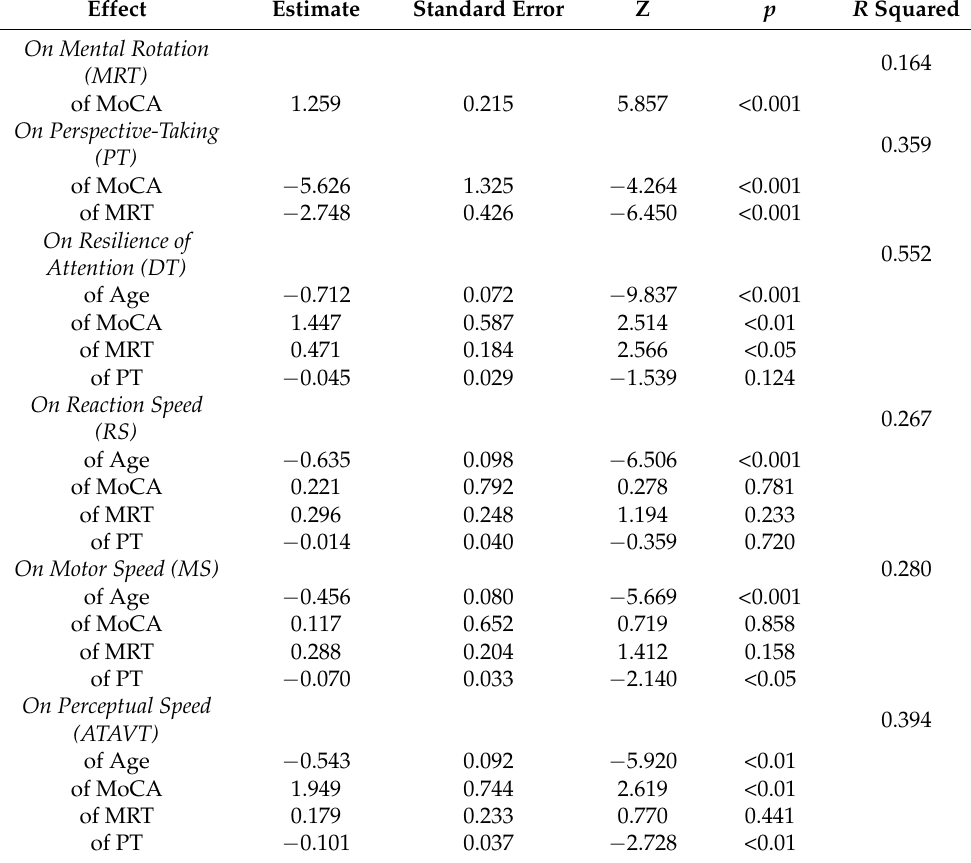
Table 2. Path analysis results: standardized estimates, standard errors, Z scores, p value, and R squared (explained variance) for each outcome and each mediation variable.